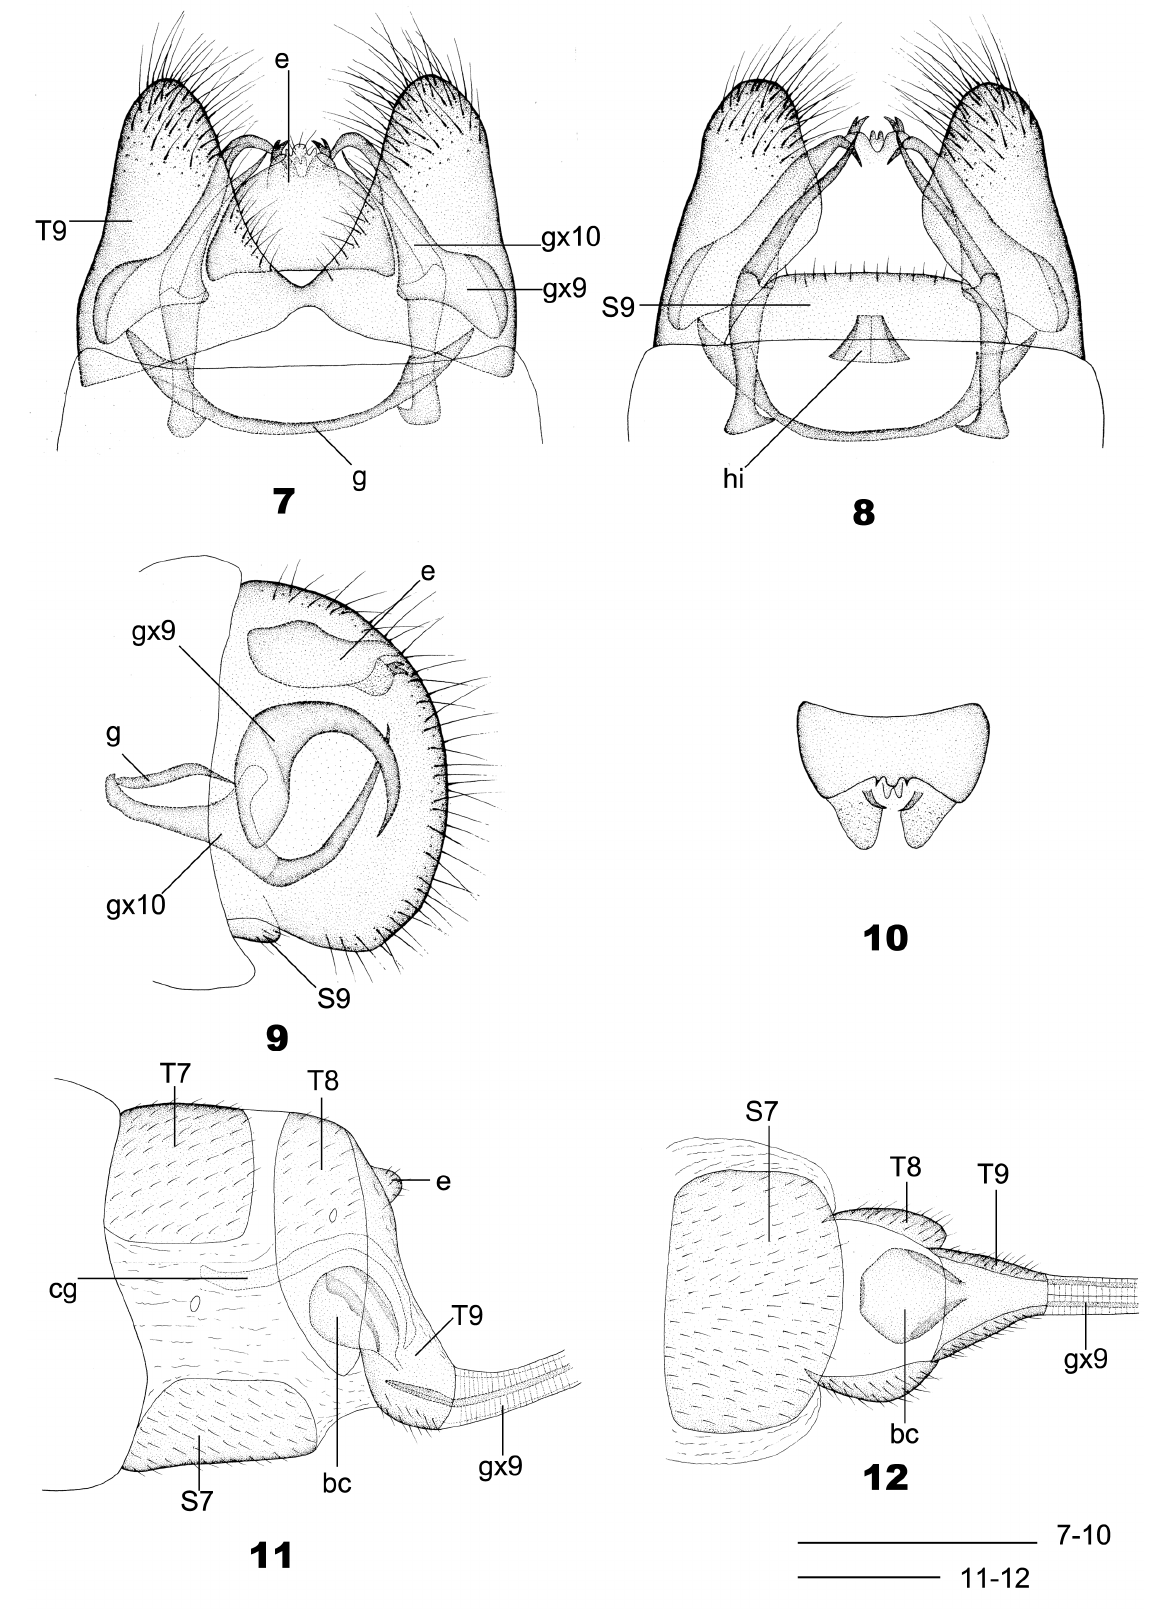
Figures 7–12. Dilar japonicus McLachlan. 7. Male genitalia, dorsal view; 8. Male genitalia, ventral view; 9. Male genitalia,